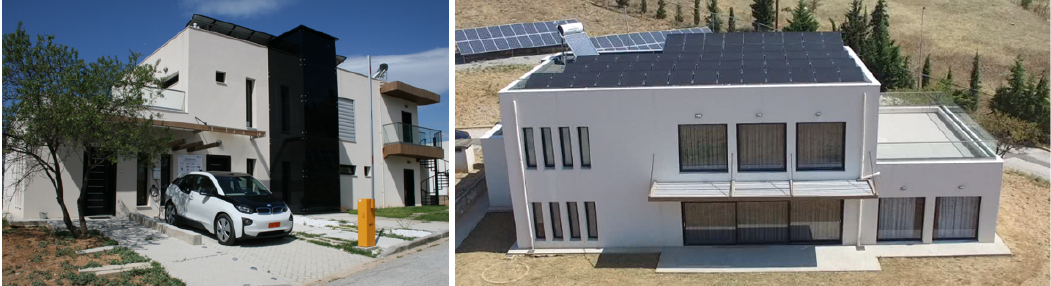
Figure 1. CERTH/ITI Smart House and the roof-based PV Installation (only the rooftop PVs are used for the current